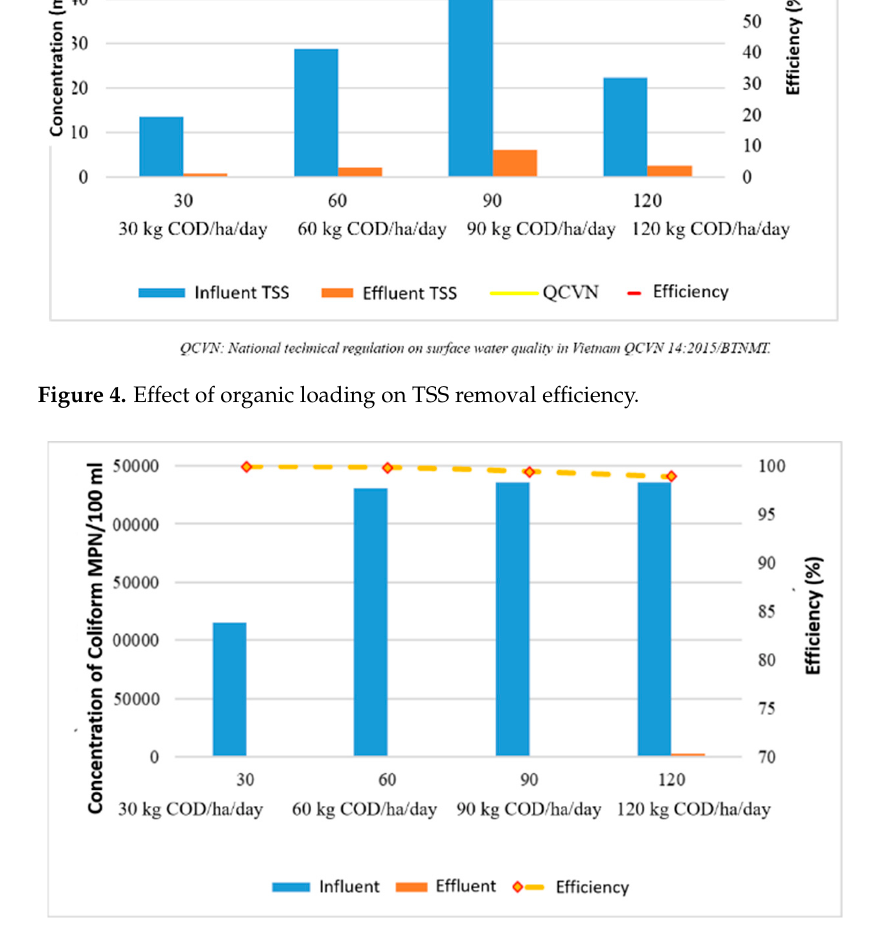
Figure 4. Effect of organic loading on TSS removal efficiency.